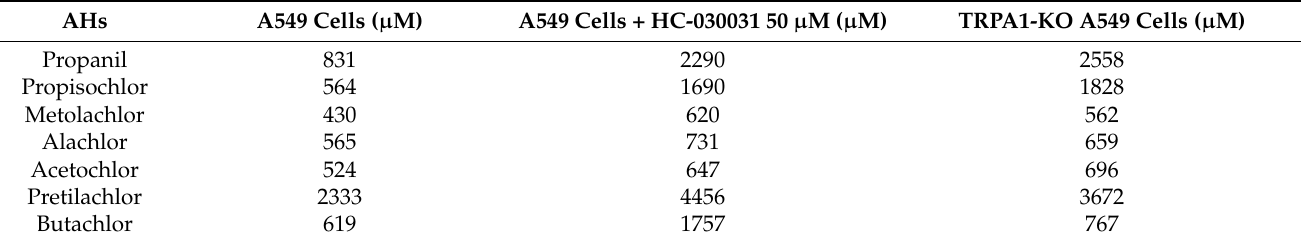
Table 1. IC 50 values of AHs in WT/ TRPA1 -KO A549